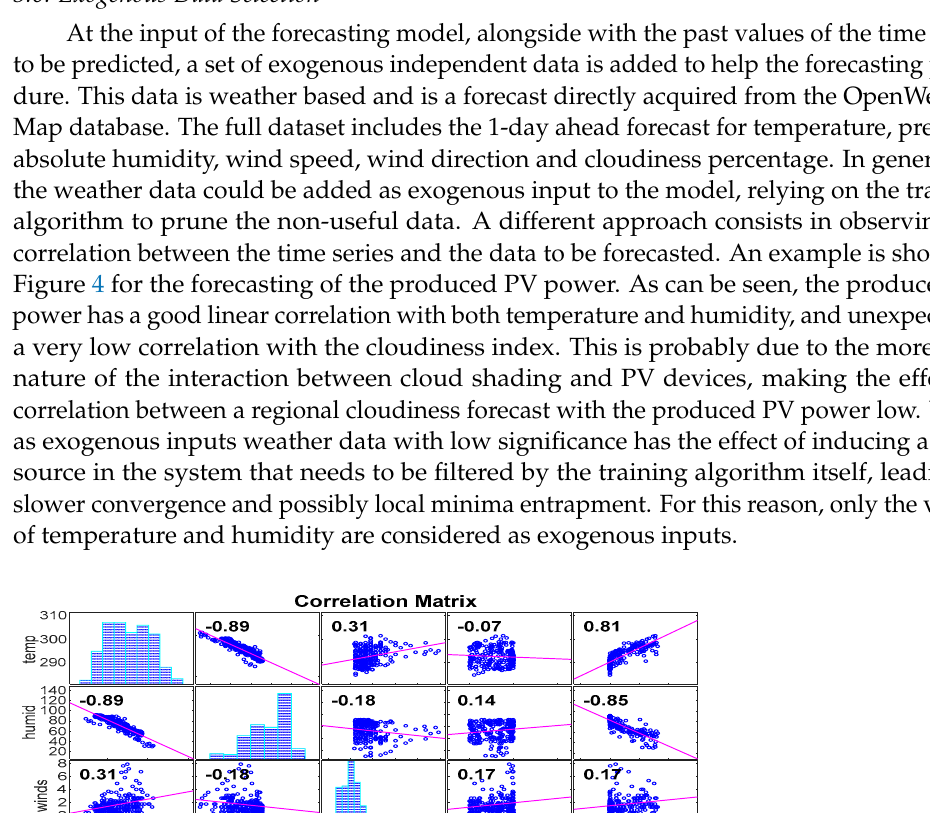
Figure 4. Example of the correlation matrix between the weather environmental variables and the produced PV power. Diagonal elements show the histogram of the variables, off-diagonal ele- ments show the scatter plot between the variables.